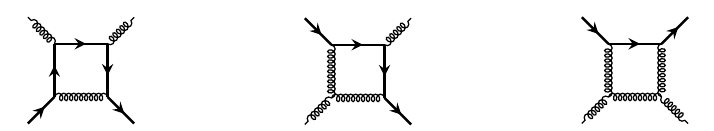
Figure 1. The three one-loop masters with mixed external particle